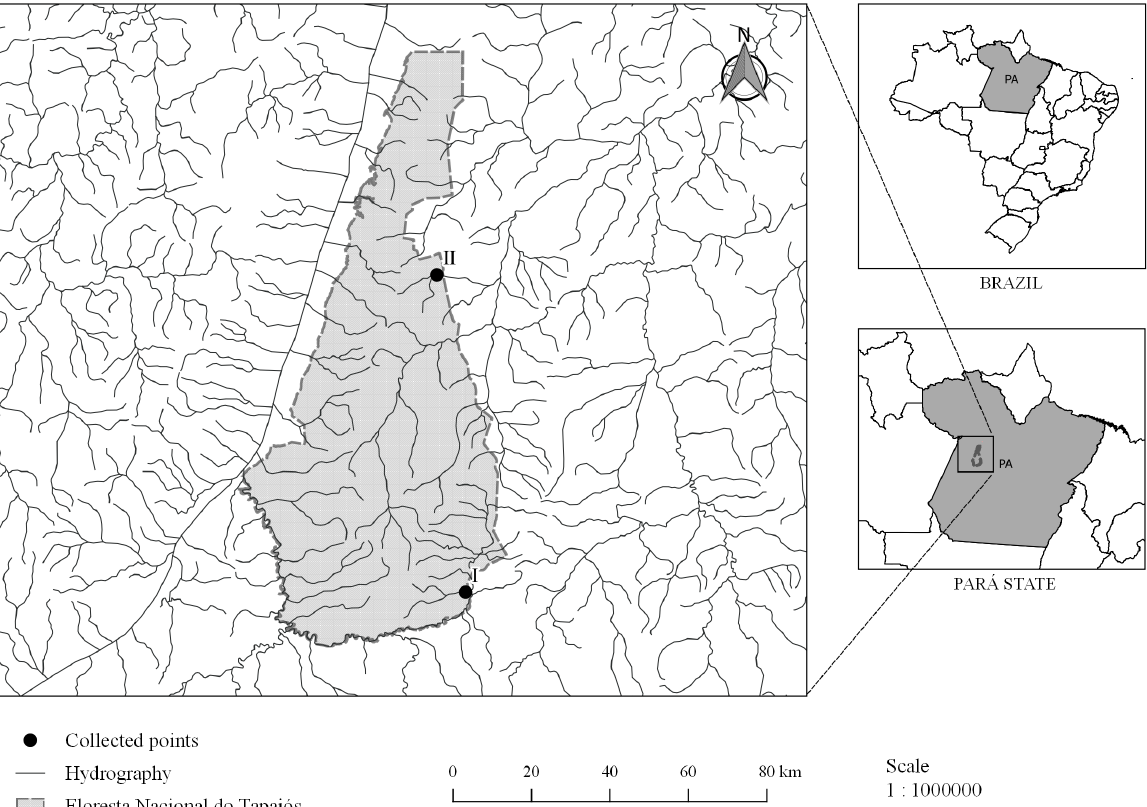
Figure 1. Map of the sites showing the low order streams and location in the Pará State, Brazil. Abbreviations: PA = Pará State; I and II = streams